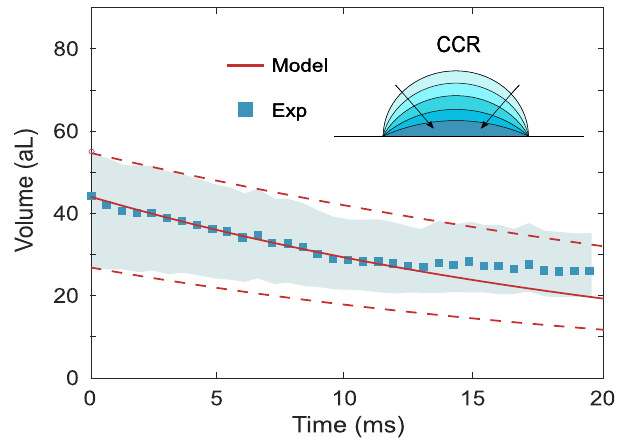
Fig. 4 | Time evolution of the nanodroplet volume. The data of Figs. 2 and 3 are shown in terms of droplet volume, over the fi rst 20ms, for the elucidated CCR mode. Blue square symbols: volume inferred from measurements, for the droplet position and initial contact radius estimated from the video frames. The uncer- tainty in these two parameters (±200nm) generates bounding scenarios for the droplet volume, which correspond to the upper and lower frontiers of the blue area.Red lines:evaporation modelsincluding theKelvineffect(seetext).The solid line is obtained with the same droplet position and initial contact radius as for the blue squares, while the dashed lines are obtained with the bounding values for these two parameters corresponding to the two bounding